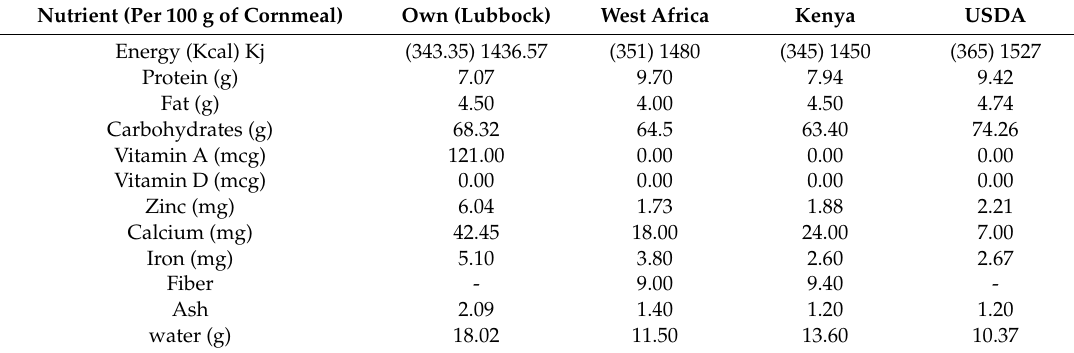
Table 5. Comparison of nutrient values of dried corn: Lubbock, West Africa, Kenya, and the USDA